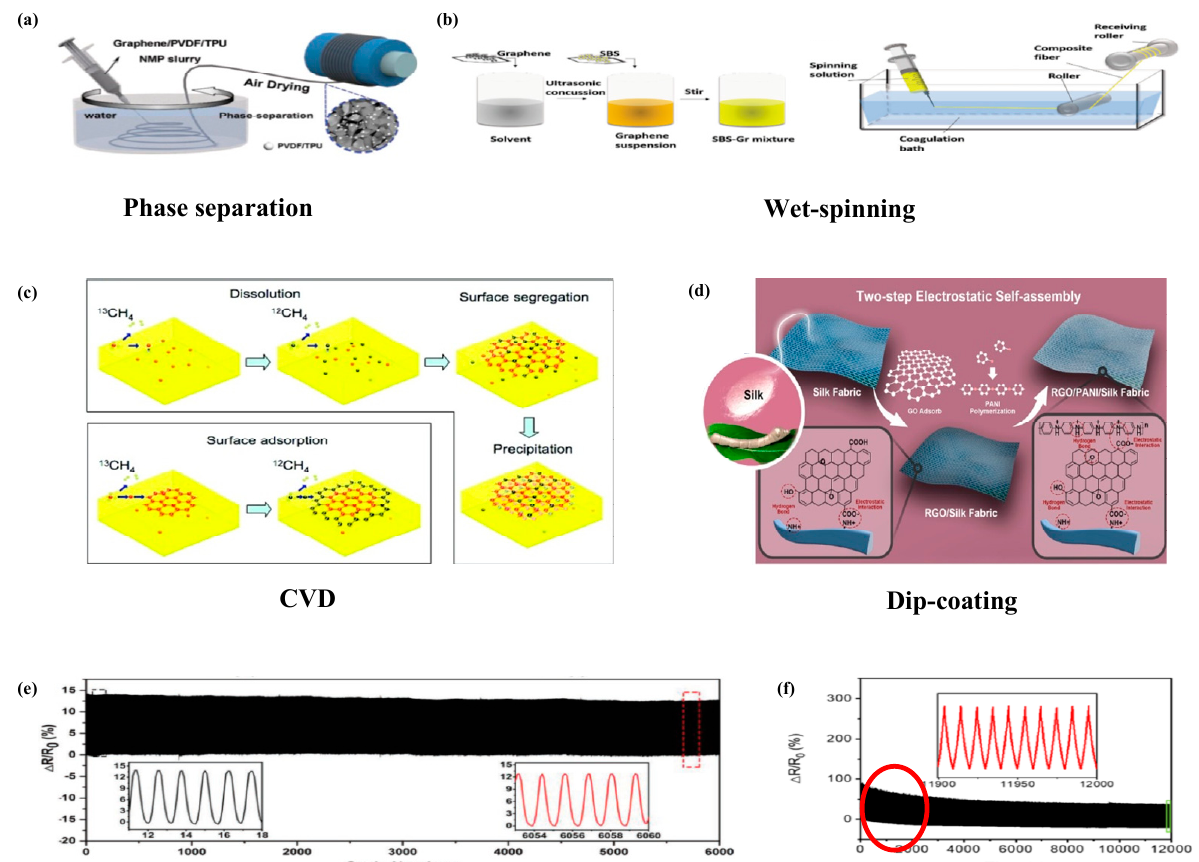
Figure 3. Fabrication and performance of graphene-based textile strain sensors. ( a ) Schematic illustration showing the fabrication of PGFs via a phase separation method. “Adapted with permission from reference [57]. Copyright [2019], Advanced Functional Materials”. ( b ) Schematic illustration for preparing poly (styrene-butadiene-styrene)/graphene composite fibers through a wet-spinning method. “Adapted with permission from reference [45]. Copyright [2020], Macromolecular Materials and Engineering”. ( c ) Durability of the PGFs strain sensors after 6000 cycles at a 1% strain stretch and release. “Adapted with permission from reference [57]. Copyright [2019], Advanced Functional Materials”. ( d )